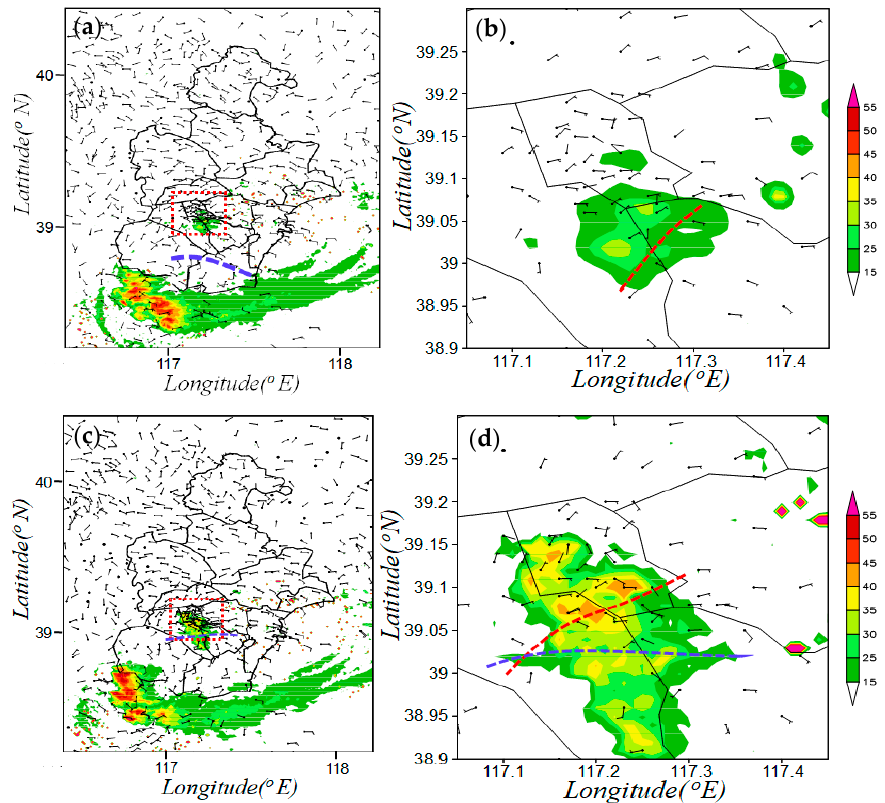
Figure 6. ( a ) Composite reflectivity (colored, unit: dBZ) at 17:42 BT and surface wind (barb, unit: m · s − 1 ) at 17:00 BT on 1 August 2019. ( b ) Enlarged view of the red dashed box in ( a ). ( c ) Composite reflectivity (colored, unit: dBZ) and surface wind (vector, unit: m ∙ s − 1 ) at 18:00 BT on 1 August 2019; ( d ) Enlarged view of the red dashed box in ( c ); the blue dashed line is the gust front and the red dashed line is the sea breeze front.